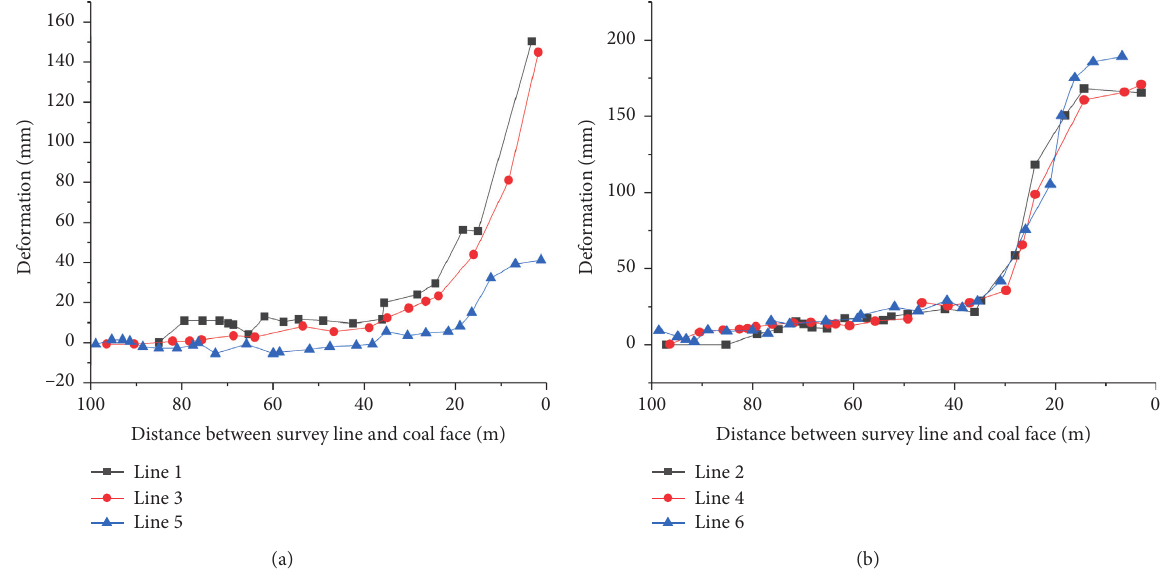
Figure 24: Displacement of two sides and roof of advance roadway. (a) Deformation of two sides of roadway. (b) Roof